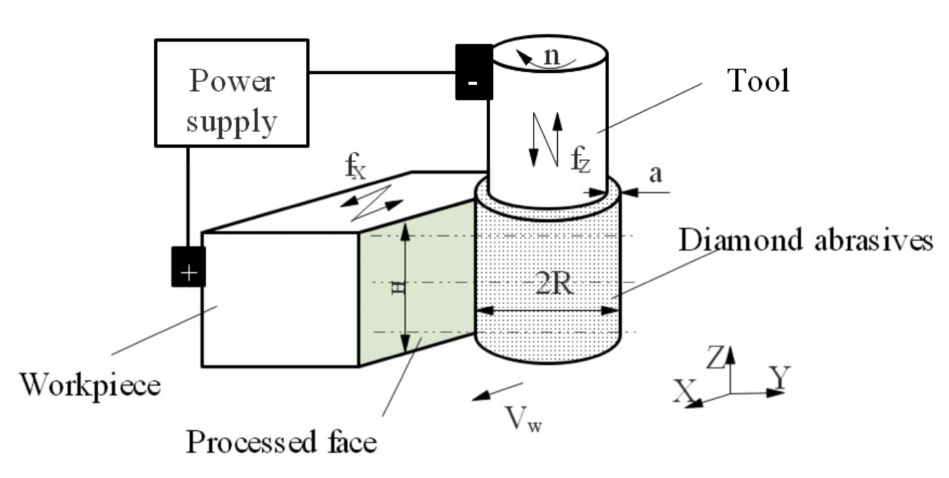
Figure 1. Schematic diagram of side-generating machining of